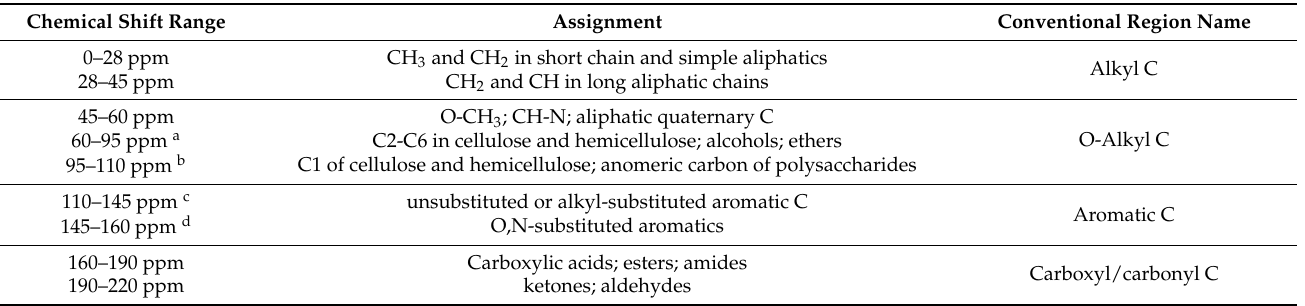
Figure 1. Typical 13 C MAS NMR spectrum of OM with division in spectral regions assigned to func- tional groups (see Table 1) and assignment to specific molecular structures. Reproduced with per- mission from Ref. [43]. Table 1. Spectral regions used in the analysis of 13 C MAS NMR spectra of OM and assignment to carbons in different functional groups.